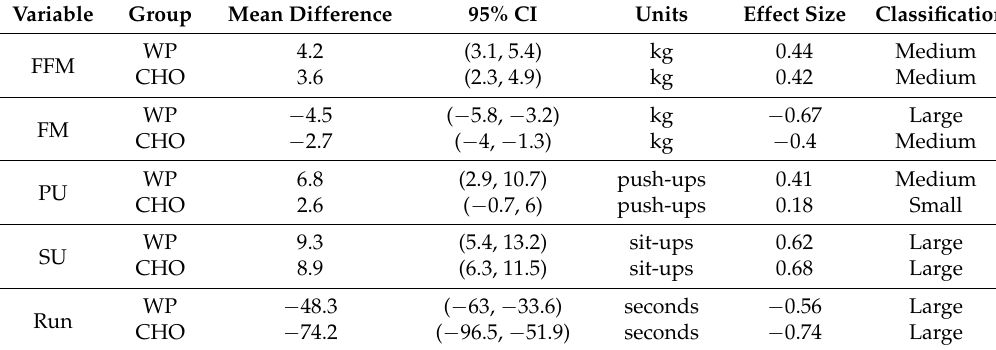
Table 3. Summary of effect sizes.